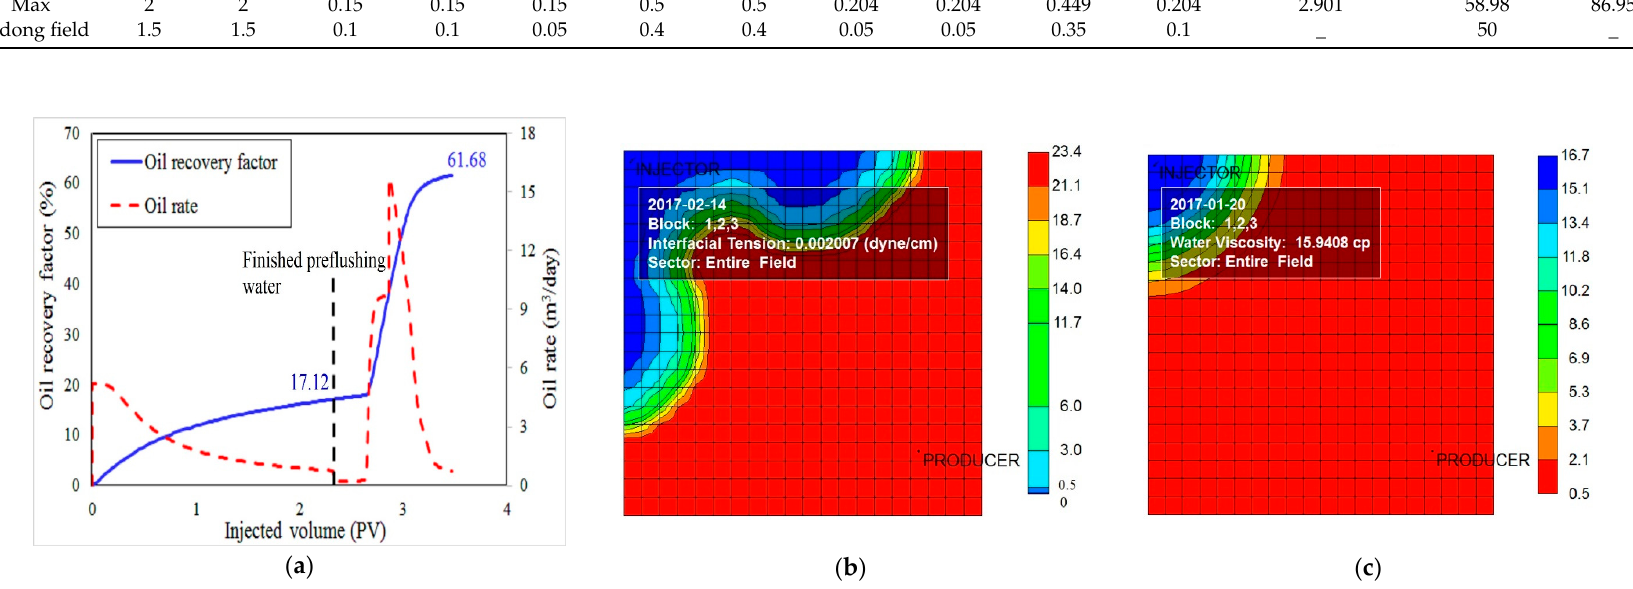
Figure 4. ( a ) Oil recovery and oil rate performance from simulation of a case which mimicked completely the designs of Gudong field; ( b ) IFT profile of this case after 0.05 PV of AS slug; ( c ) Profile of viscosity of displacing fluid after 0.05 PV of the first polymer slug. The IFT in the swept region can be reduced to 0.002007 dyne/cm, while the viscosity of first polymer solution is nearly 16 cp, which indicate the expected designs of chemical agents.